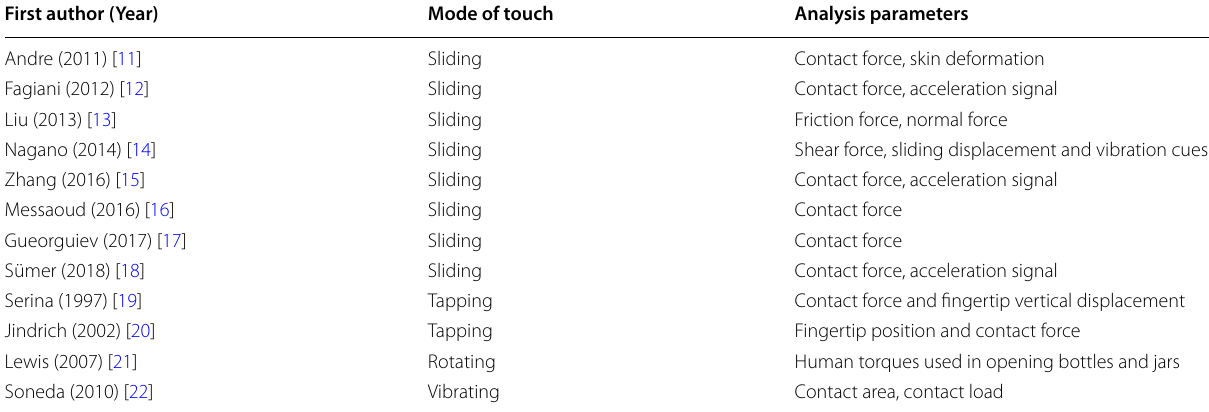
Table 1 Experimental devices used in previous research for different modes of touch including sliding, tapping, rotating and vibrating First author